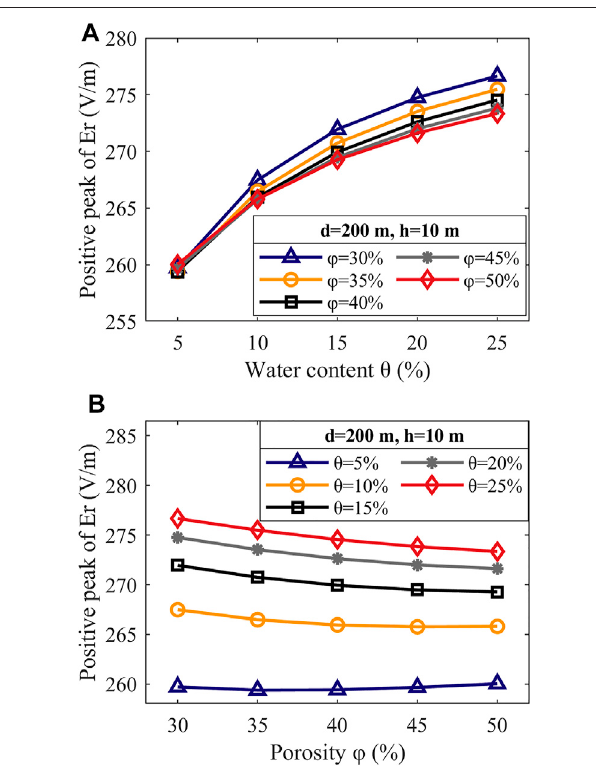
FIGURE 6 | (A) In fl uence of water content on FDTD-computed subsequent return stroke waveforms of the horizontal electric fi eld (Er) at different porosities φ (cid:2) 30%, 35%, 40%, 45%, and 50%. The water content θ is set to 5%, 10%, 15%, 20%, and 25% (d = 200 m, h = 10 m). (B) In fl uence of porosity on FDTD-computed subsequent return stroke waveforms of the horizontal electric fi eld at different water contents θ (cid:2) 5%, 10%, 15%, 20%, and 25%. The porosity φ is set to 30%, 35%, 40%, 45%, and 50% (d = 200 m, h = 10 m).